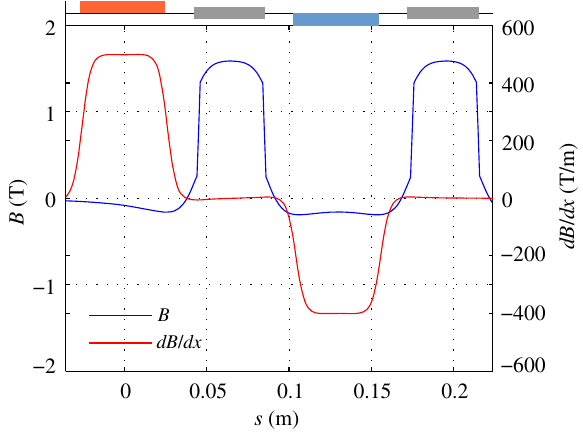
ffiffiffiffiffiffiffiffiffiffiffiffiffiffiffiffiffiffiffiffiffiffiffi p ¯ β ε þ δ 2 ¯ η 2 x x